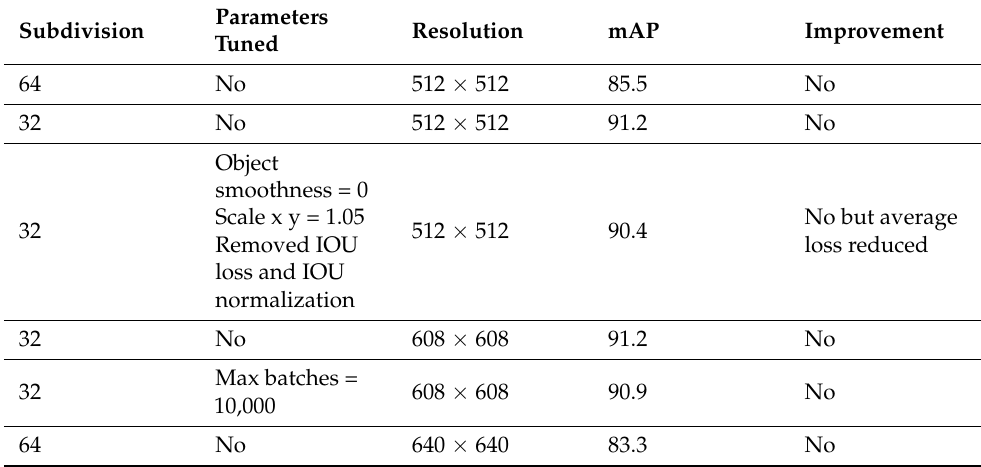
Table 3. Model 1: Scaled-YOLOv4 Optimization Configuration, and Parameter Tuning using GPU RTX